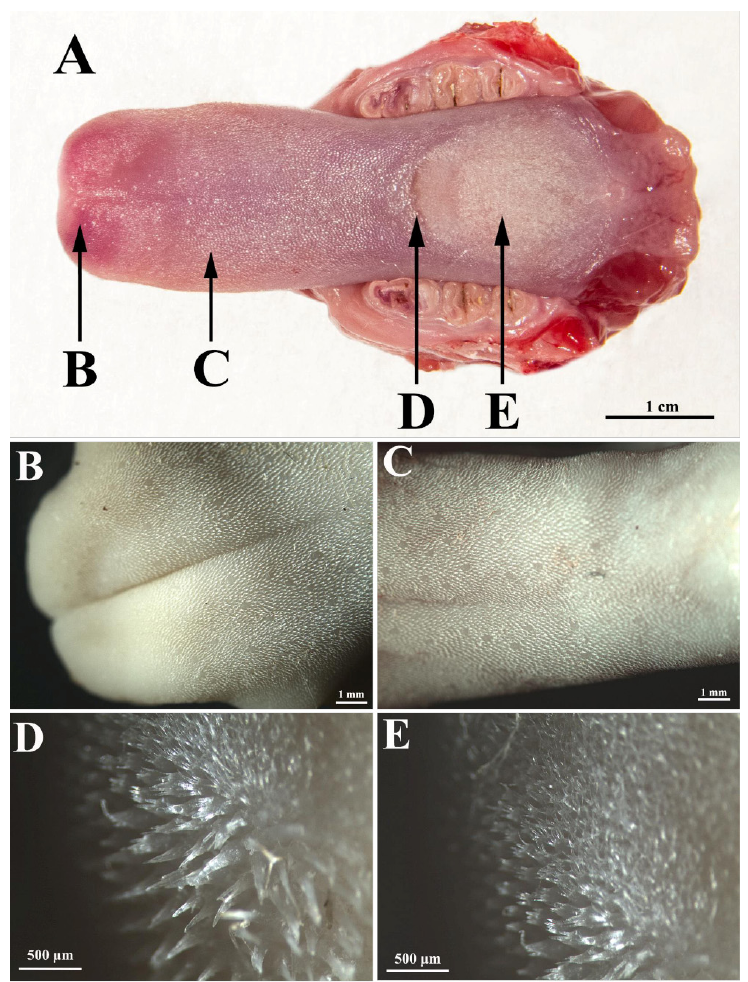
Figure 1. Gross features of the tongue of the white Wistar rat: ( A ) the organ as a whole that includes the apex, the anterior portion of the lingual body, the protuberance, and the posterior portion of the lingual body; ( B ) the lingual apex that includes the shortest filiform papillae of all the tongue, with a sharp tip and a pronounced anteroposterior inclination (claw appearance); ( C ) the anterior portion of the lingual body displaying slightly taller filiform papillae (vs. the apex) with an anteroposterior orientation and slightly lower density (vs. the apex); ( D ) tongue protuberance showing the tallest filiform papillae compared to all other regions of the tongue, with a posteroanterior-inclined conical tip; ( E ) the posterior part of the body of the tongue covered with anteroposteriorly inclined papillae that are slightly shorter vs. the ones from the